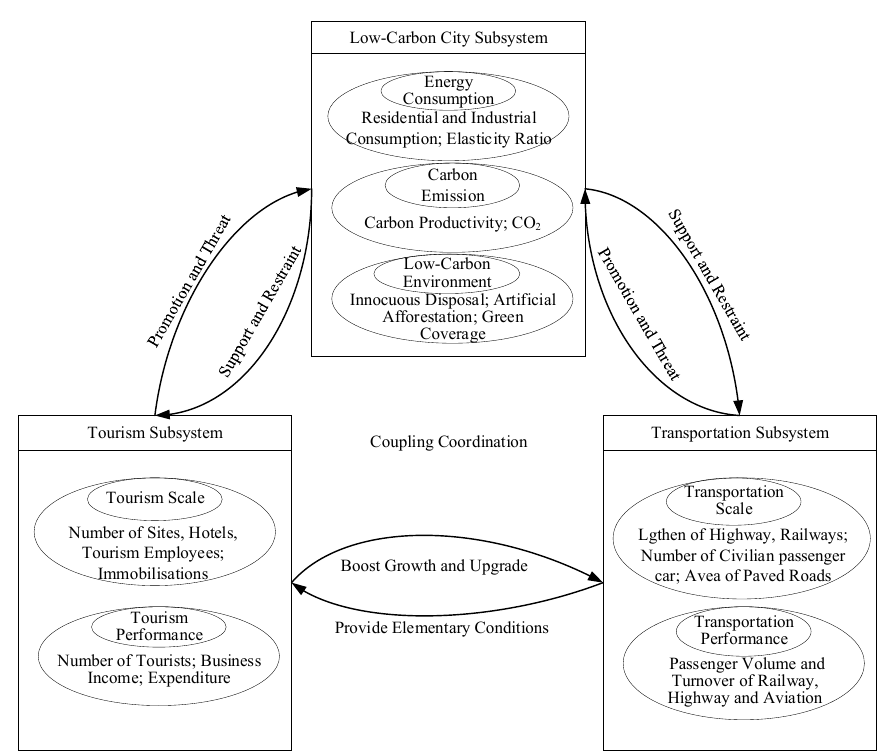
Figure 1. Relationship between tourism, transportation and low-carbon cities.